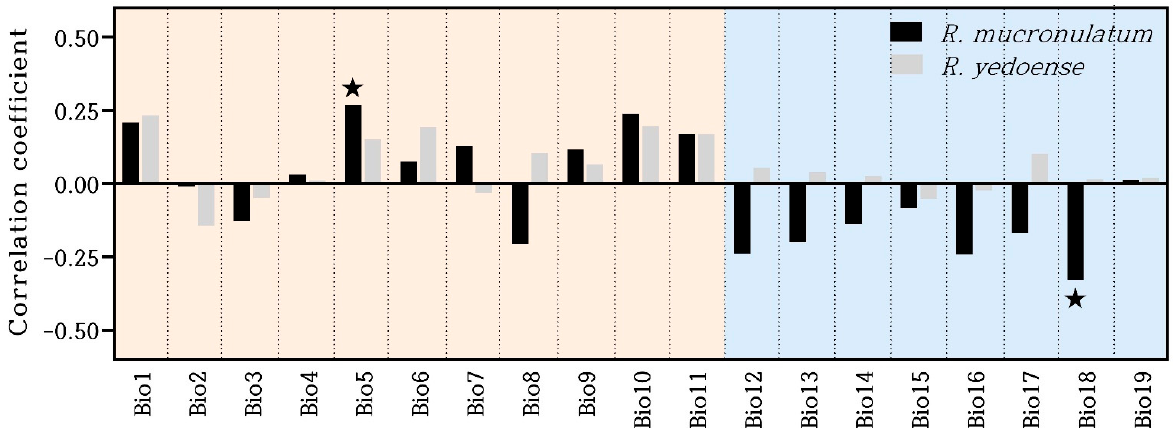
Figure 7. Correlation coefficients between residual chronologies of Rhododendron spp. and BioClim variables (Bio1: annual mean temperature (hereafter temp), Bio2: mean diurnal range, Bio3: isother- mality, Bio4: temp seasonality, Bio5: max temp of the warmest month, Bio6: min temp of the coldest month, Bio7: annual temp range, Bio8: mean temp of wettest quarter, Bio9: mean temp of driest quarter, Bio10: mean temp of warmest quarter, Bio11: mean temp of coldest quarter, Bio12: annual precipitation (hereafter prec), Bio13: prec of the wettest month, Bio14: prec of the driest month, Bio15: prec seasonality, Bio16: prec of wettest quarter, Bio17: prec of driest quarter, Bio18: prec of warmest quarter, Bio19: prec of coldest quarter, star mark: p < 0.05).